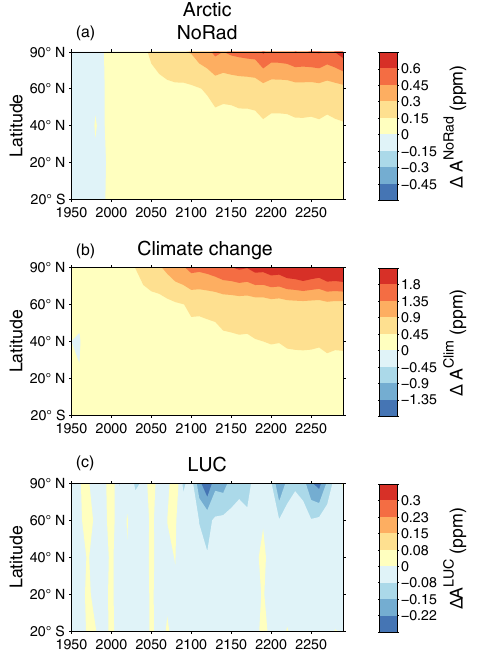
Figure 12. As in Fig. 8 but for (a) CO 2 fertilization + N deposition, (b) climate change, and (c) LUC from the Arctic. Note that the color scales are different in each